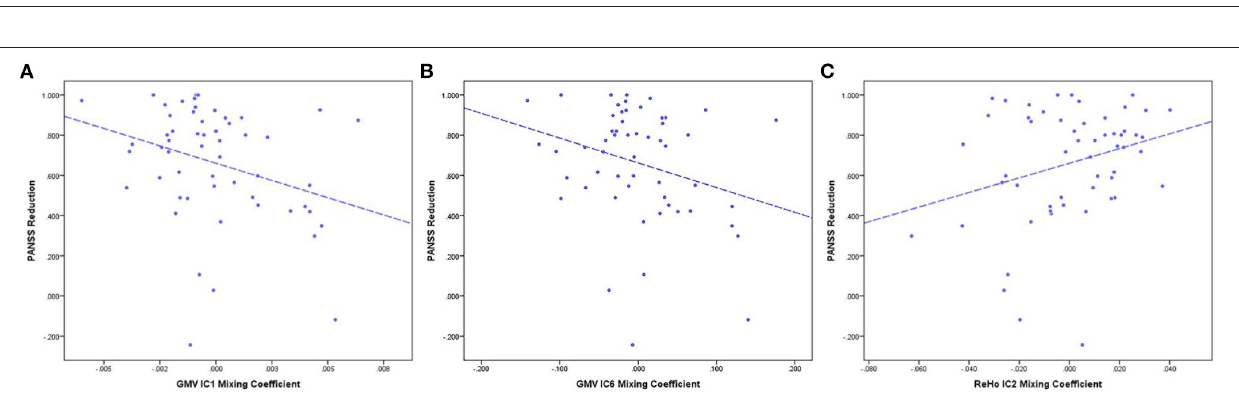
FIGURE 4 | PANSS reduction and mixing coefficient correlations between the RG and NRG. (A) The correlation of PANSS reductions and GMV-IC1 mixing coefficients. (B) The correlation of PANSS reductions and GMV-IC6 mixing coefficients. (C) The correlation of PANSS reductions and ReHo-IC2 mixing coefficients. PANSS, Positive and Negative Syndrome Scale; RG, responder group; NRG, non-responder group; IC, independent component; GMV, gray matter volume; ReHo, regional